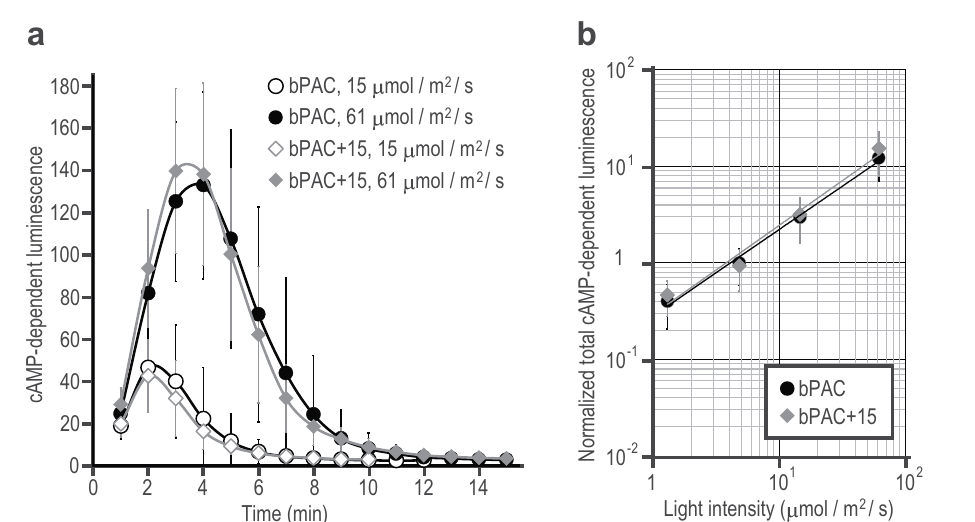
Figure 4. The C-terminal region of OaPAC did not affect the activity of bPAC. HEK cells expressing bPAC or bPAC + 15 were illuminated with blue light, and the cAMP yield was detected as luminescence. ( a ) Representative cAMP-dependent luminescence every 1 minute after blue light illumination is shown at indicated intensities. ( b ) Normalized total cAMP-dependent luminescence of bPAC and bPAC + 15 versus blue light intensities is shown. Data were collected from different cells. Bars indicate mean ± S.D. (n ≥